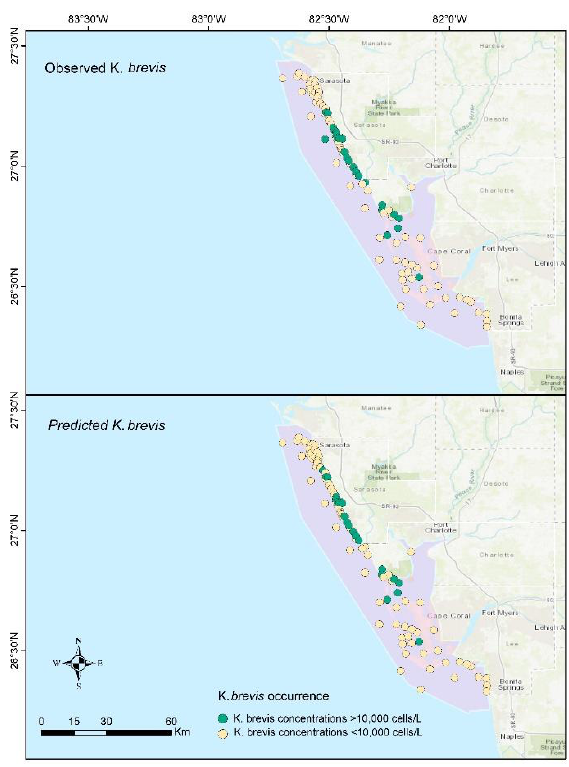
Figure 5. Comparison between the reported K. brevis concentration in 170 randomly selected test samples within the study area (top) with their predicted concentrations from an 8-day RF model (bottom). The samples have been classified correctly with 95% accuracy.